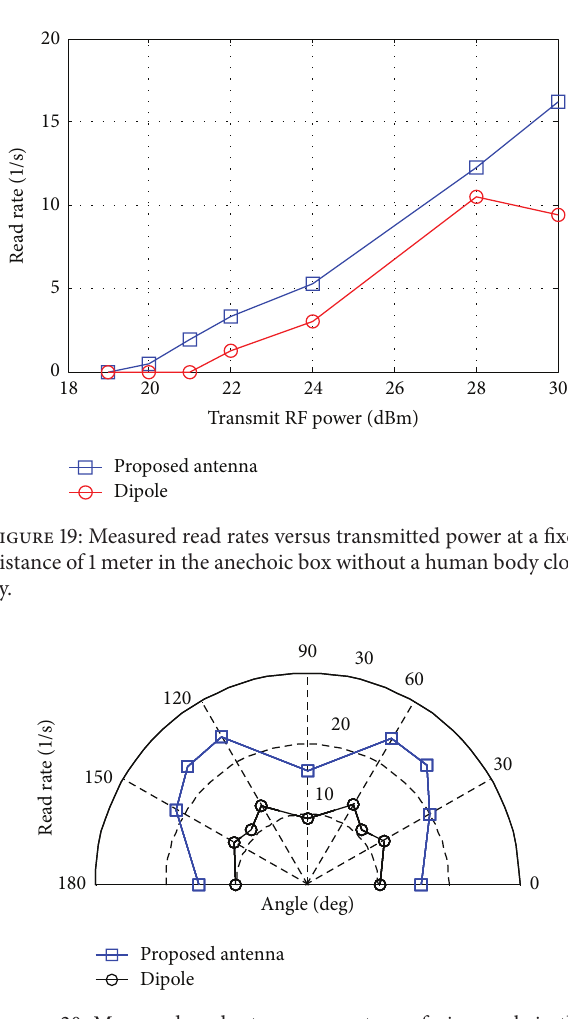
Figure 20: Measured read rates versus antenna facing angle in the anechoic